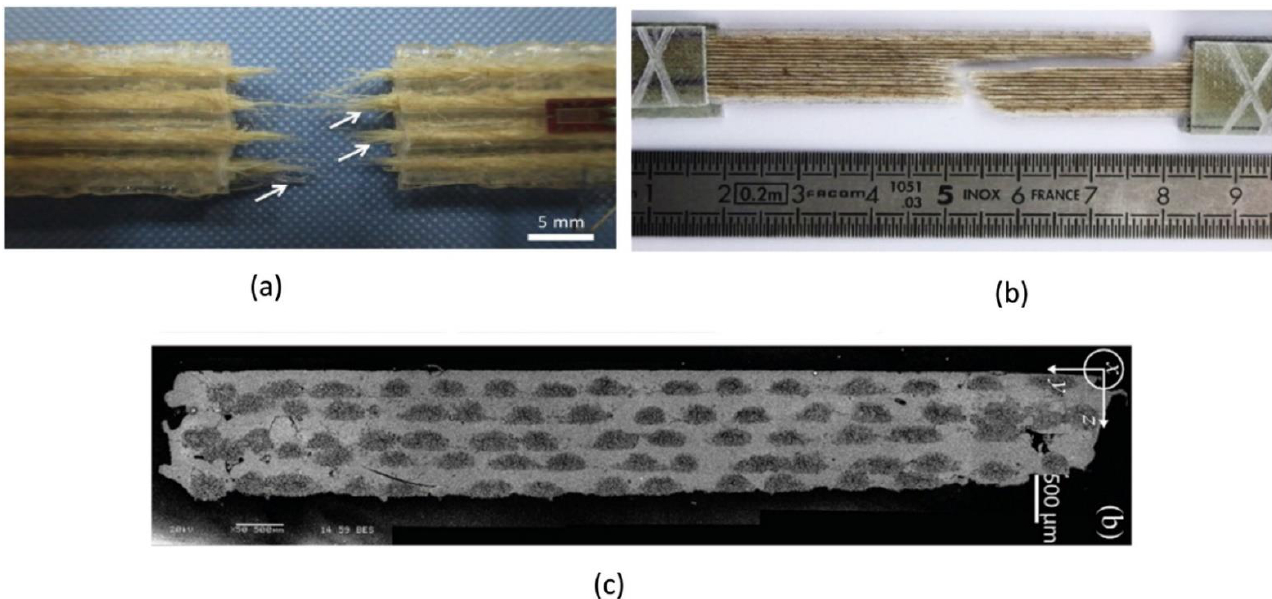
Figure 7. Continuous natural fibre ( a ) Fractured continuous unidirectional jute fibres/PLA sample printed with in-nozzle reinforced with various fibre debonding. ( b ) Fractured continuous unidirectional flax fibre/PLA sample printed with pre-impregnated filaments with a transverse crack followed by propagation along the tensile axis. ( c ) SEM micrograph of a cross-section of Flax/PLA composite microstructure. Adapted with copyright permission from Le Duigou et al. [143] and Matsuzaki et al. [161].